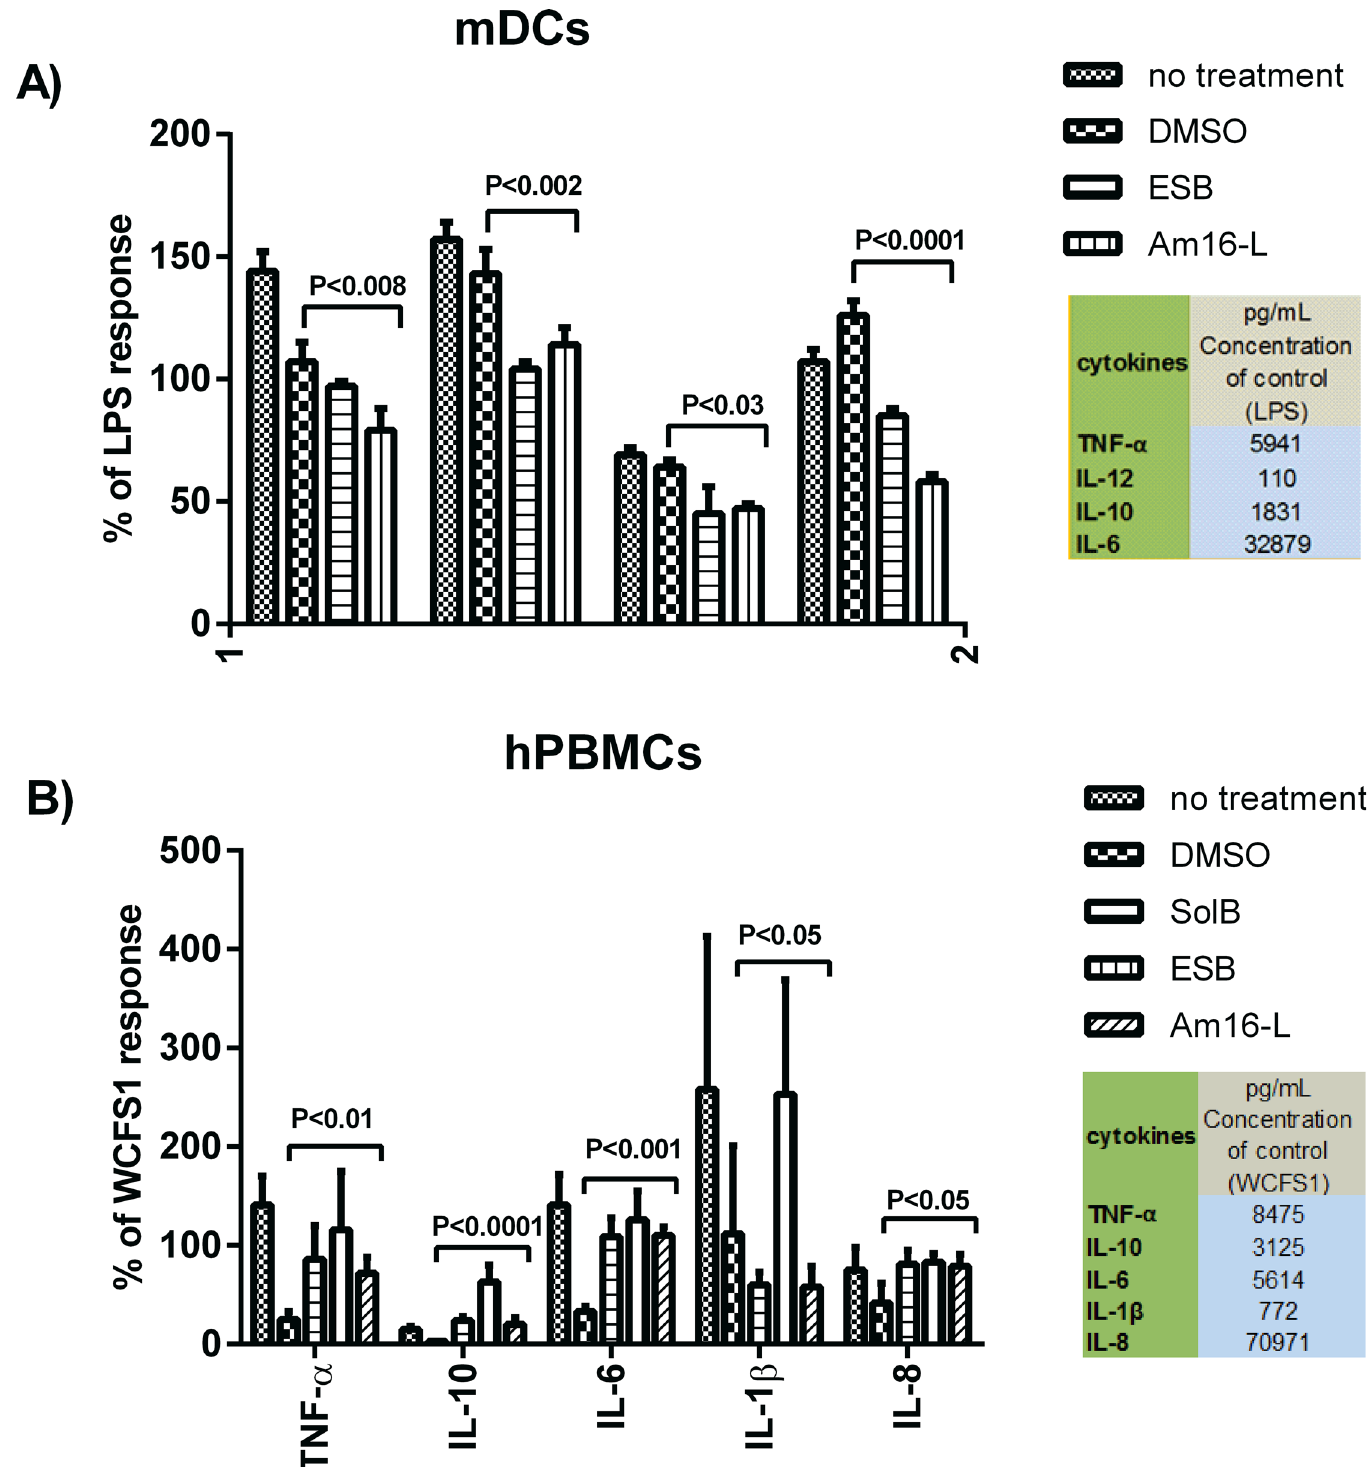
Fig 6. Solonamide-treated S . aureus influence cytokine production by immune cells. Bone marrow derived murine dendritic cells (A) and human peripheral blood mononuclear cells (B) were stimulated at an MOI of 10 with S . aureus strain 8325 – 4 pre-treated with SolB (2) ESB (4), Am16-L (9) or DMSO at 10 μ g/mL. Protein concentrations of selected cytokines in the supernatants after 20 – 24 h incubation were measured by enzyme-linked immunosorbent assay for DCs and by cytometric bead array for human PBMCs. The results are based on 3 biological replicates and are normalized to the stimulus controls (LPS for DC; L . plantarum WCFS1 for PBMCs). Comparisons were made between the DMSO compound vehicle and the